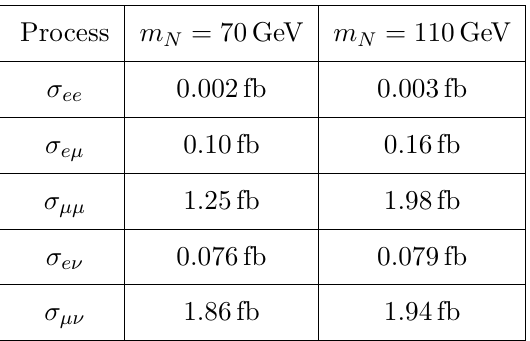
Table 3 . Cross sections corresponding to the final states l + l 0 +jets and l + ν +jets ( l, l 0 = e, µ ) at the 14 TeV LHC (using σ 0 = 40 . 8 fb and omitting uncertainties), for m N = 70 GeV and m N = 110 GeV and in the maximal mixing case. The other model parameters are the same as in table